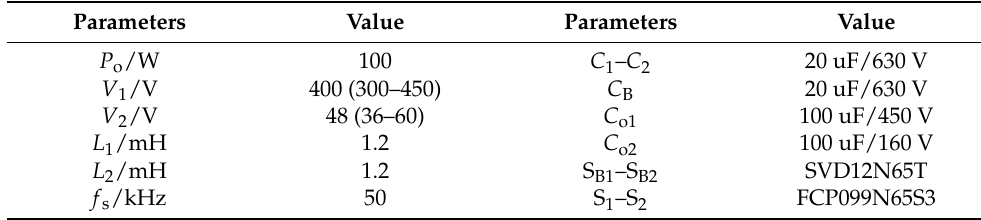
Figure 14. Prototype of the proposed converter. Table 2. Parameters of an experimental